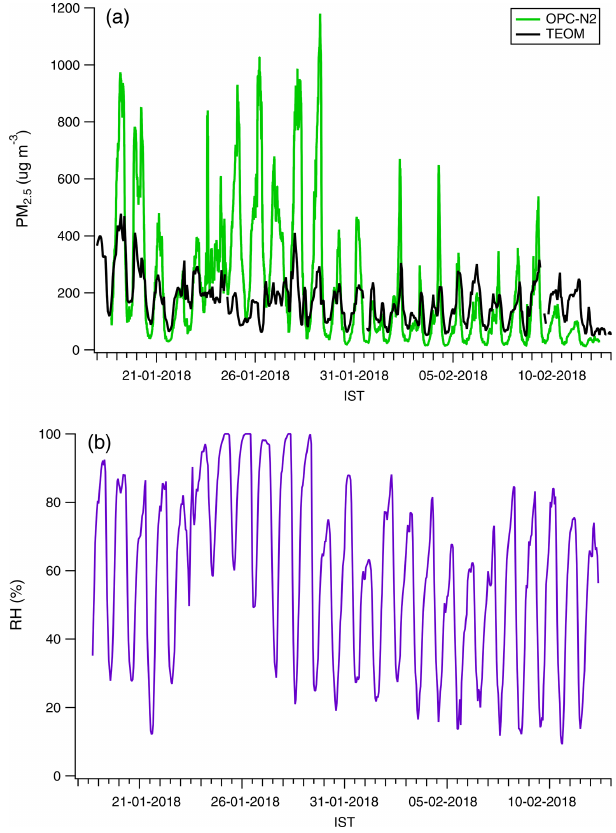
Figure 6. Time series of reported OPC-N2 and TEOM-FDMS PM 2 . 5 mass concentrations (a) and ambient RH (b) at IIT